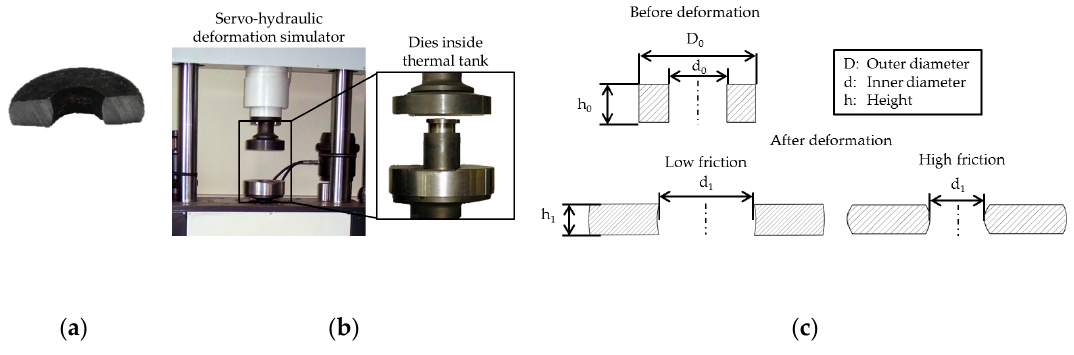
Figure 1. Deformed ring compression sample ( a ); Experimental ring compression setup on servo-hydraulic deformation simulator WUMSI with thermal tank ( b ); Schematic representation of ring compression test for different friction conditions ( c ).